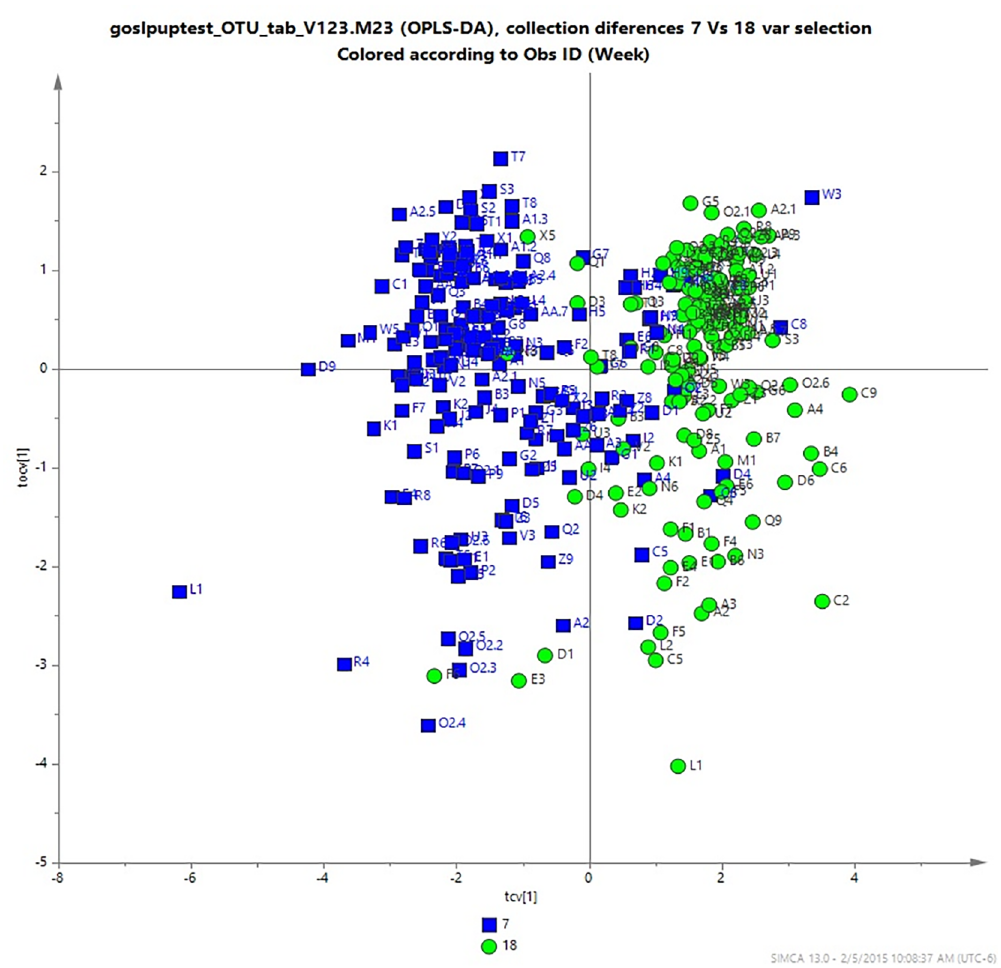
Fig 1. An OPLS-DA revealed differences in composition of the microbiota of dogs related to age. The OPLS-DA plot shows a comparison of the fecal microbiota in 7 weeks old puppies (blue) and when they becomes 15–18 months old (green), OPLS-DA; Q 2 =